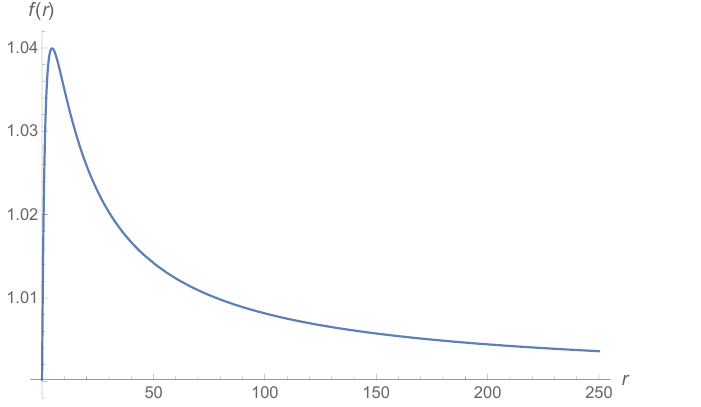
Figure 4 . Comparison between the numerical solution for g (blue) and g 0 (orange) for A = 1.